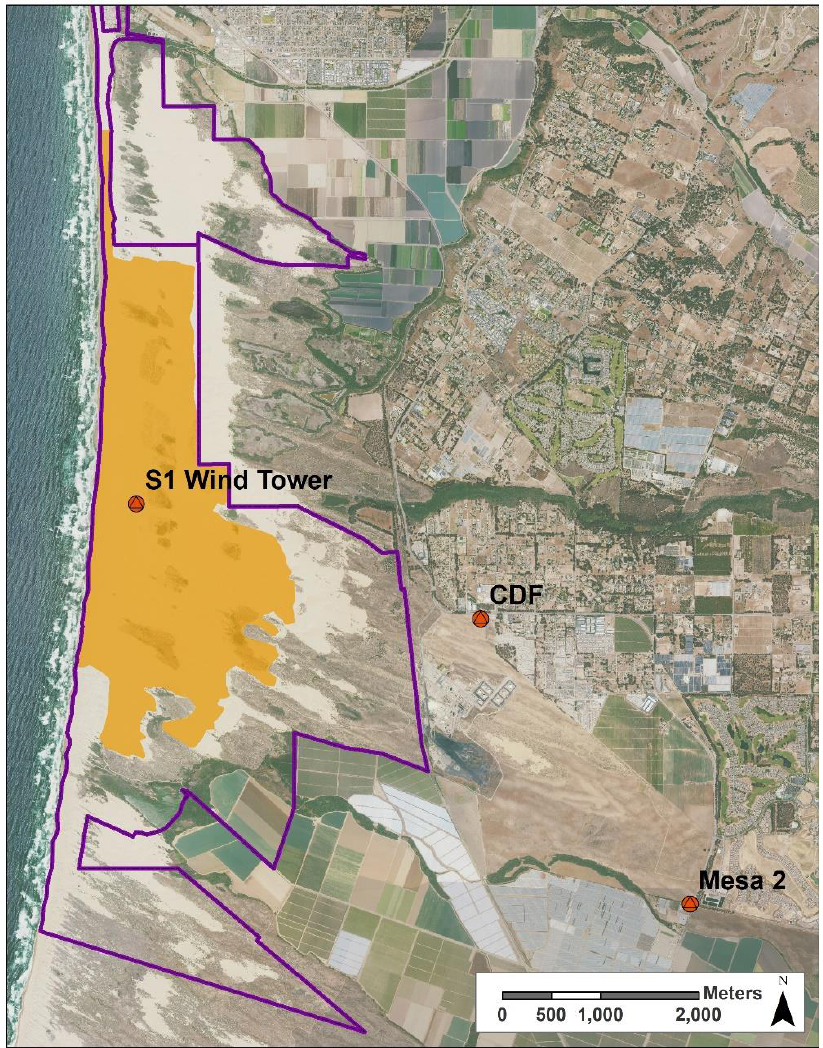
Figure 1. The location of the APCD’s environmental monitoring station, the CDF, with respect to the ODSVRA. The shaded area demarcates the riding area of the ODSVRA. The solid purple line demarcates the boundary of the ODSVRA. A red circle in the shaded area identifies the location of a 10 m tower designated as S1, where in-park meteorological data are collected, and Mesa2 is another of the APCD’s monitoring stations.